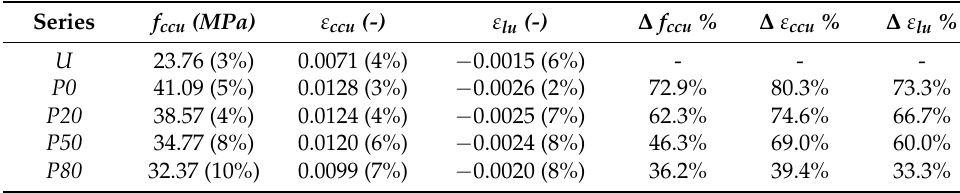
Table 2. Average values of the tests result and CoV in